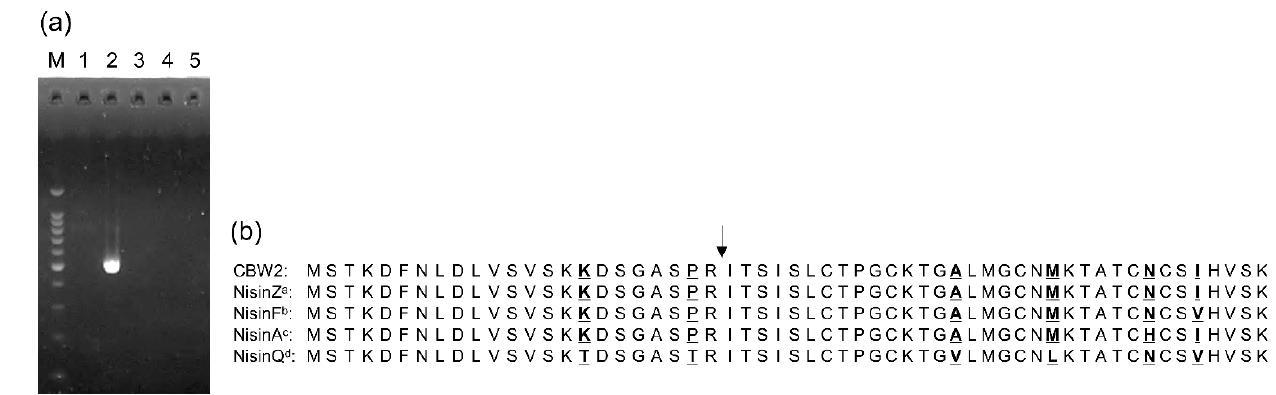
Figure 3. Specific PCR amplification of the structural gene for the nisin precursor ( nisA ) ( a ) and alignment of the proposed prepeptide sequences of the nisin variant ( b ). Lane M shows the 100-bp ladder marker from 100 to 1000 bp and 1500 bp and lanes 1–5 represent the CBW1, CBW2, CBW3, CBW4, and CBW5 strains, respectively. The National Center for Biotechnology Information (NCBI) GenBank accession numbers are: a CAA79467, b ABU45463, c CAA48380, and d BAG71479. Vertical arrow indicates a processing site. Substituted residues are marked in bold and underlined.